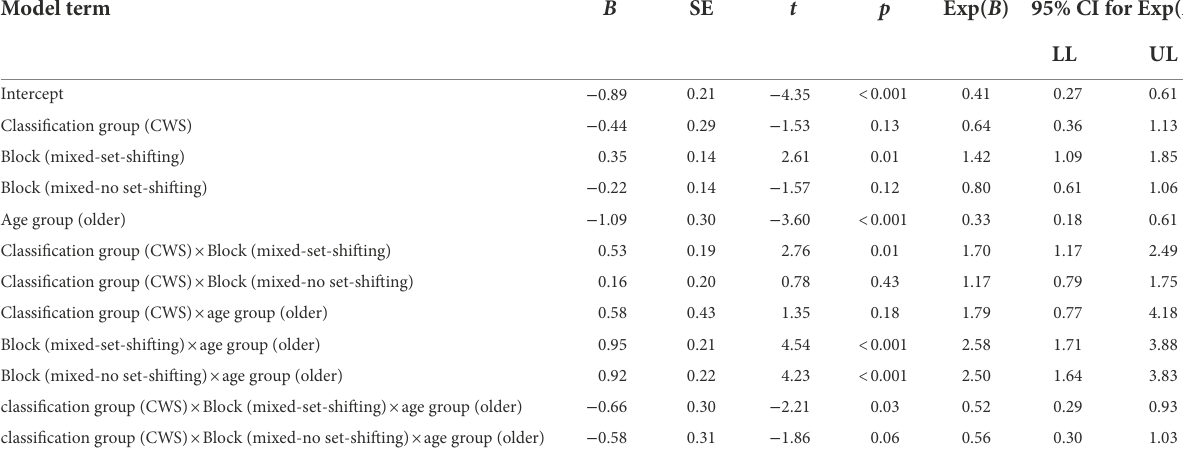
TABLE 5 Fixed coefficients for classification group, age group, and block for the incompatible trials analysis of accuracy. Model